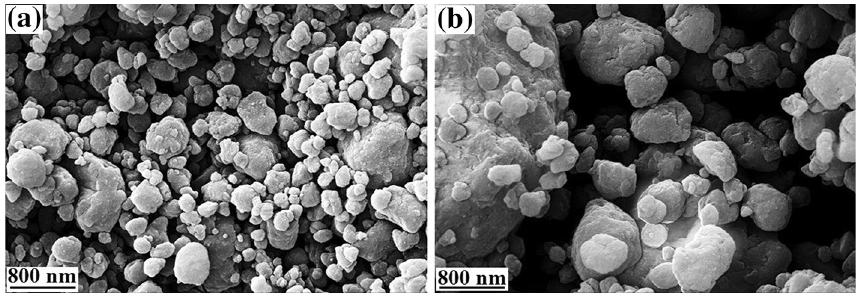
Fig. 12 SEM images of MgH 2 -10 wt% of mischmetal ball-milled for a 20 and b 30